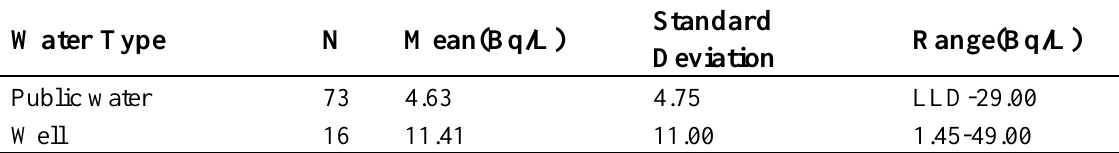
Table 1. Radon concentrations for various water